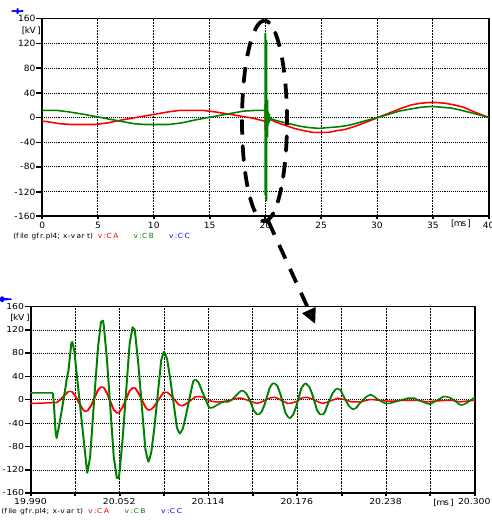
Fig. 17. The transformer secondary side terminal voltage.